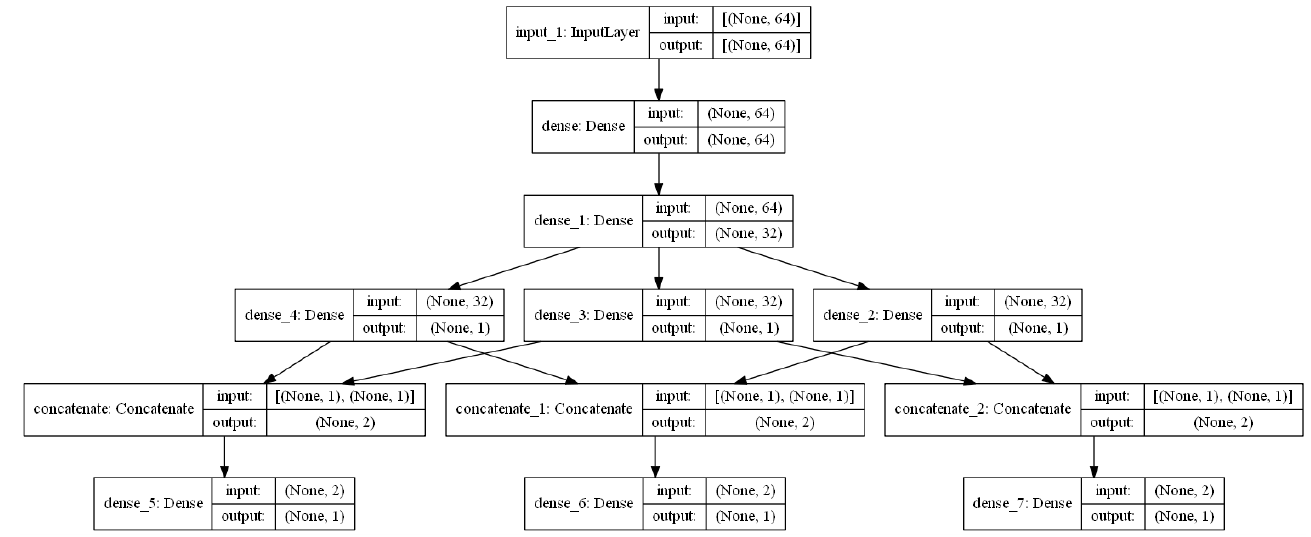
Figure 2. Multi-output model architecture.